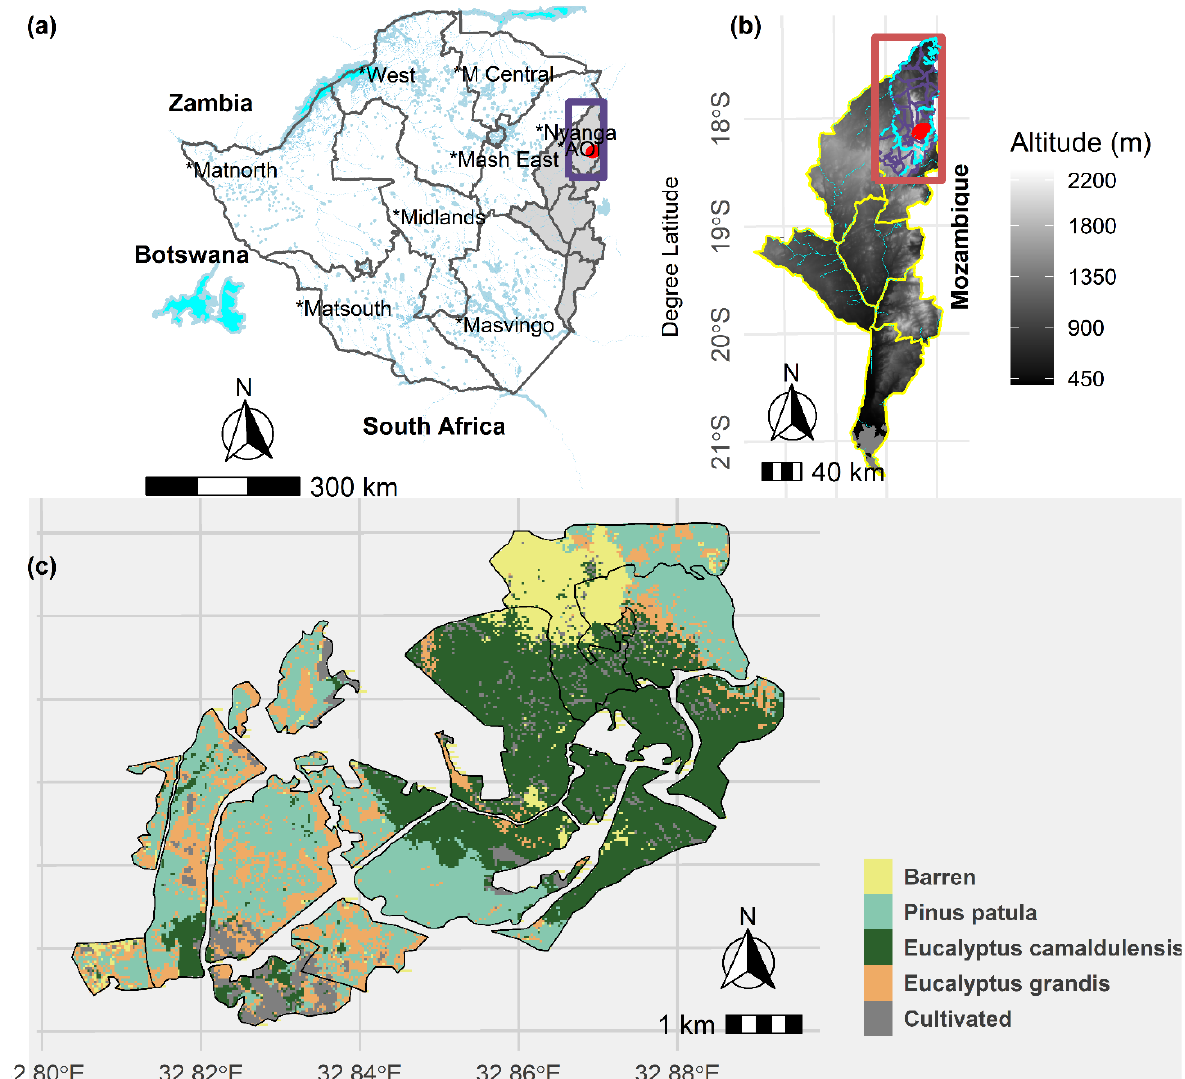
Figure 1. Map of the study area indicating ( a ) the province where samples were derived, ( b ) the study area location within the particular province, and ( c ) the spatial distribution of major plantation tree species in the studied region. * Refers to Provinces in Zimbabwe whilst the box encompasses the studied area in this research.